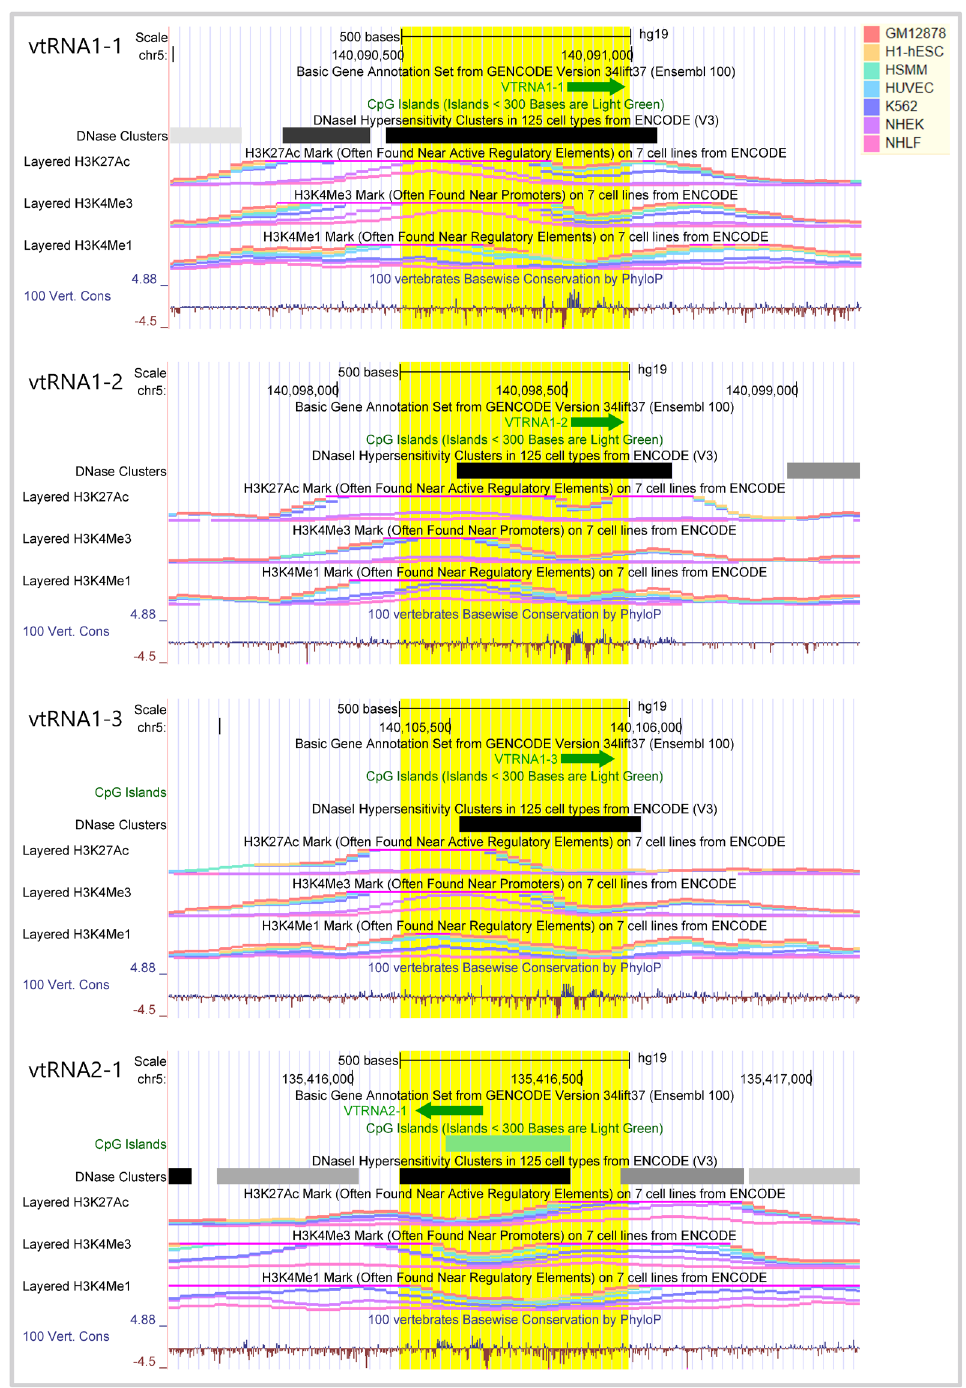
Figure 1. Genomic view of human vtRNA genes epigenetic features. Genomic view of 1.5 kb region of human vtRNA genes in UCSC Genome browser (GRCh37/hg19) centered at the 500bp bin highlighted in yellow, which was used for ATAC-seq and CpG methylation analyses. VtRNAs of locus 1 cluster (vtRNA1-1, vtRNA1-2, vtRNA1-3) and of locus 2 (vtRNA2-1) are in the sense and antisense orientation respectively. Several Gene annotation and ENCODE Project tracks for seven cell lines (GM12878, H1-hESC, HSMM, HUVEC, K562, NHEK, NHL) are displayed: DNA accessibility (DNaseI hypersensitivity clusters (color intensity is proportional to the maximum signal strength)), DNA methylation (for CpG islands length greater than 200 bp), histone modification (H3K27Ac, H3K4me1, H3K4me3 marks), conservation of the region in 100 Vertebrates (log-odds Phylop scores). The vertical viewing range of the tracks displays the default settings of the browser for each variable.